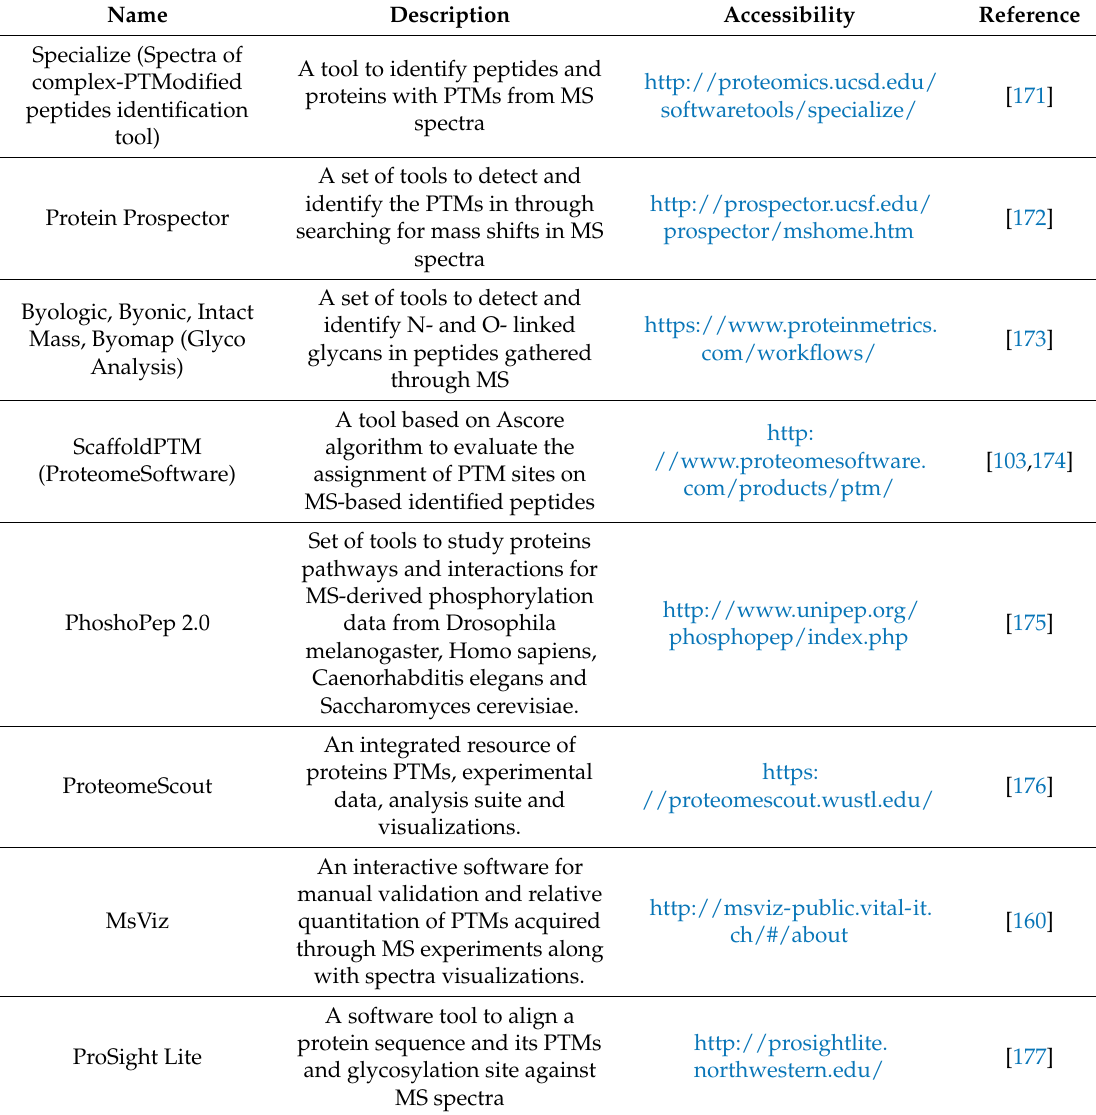
Table 3. Examples of recent MS-specific PTM related